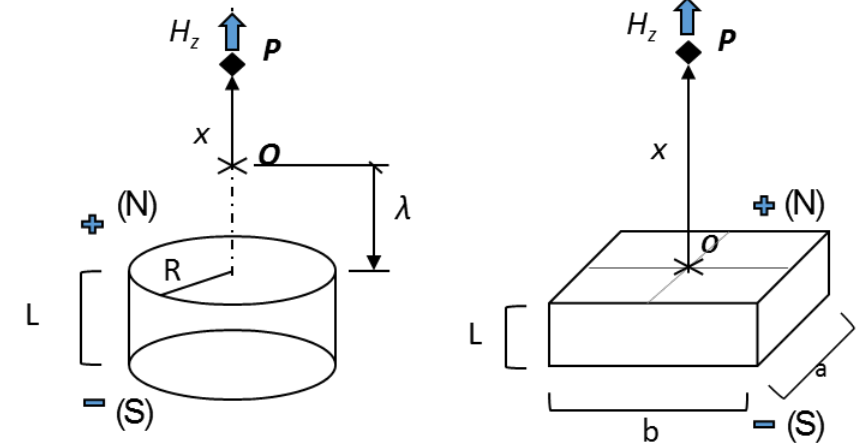
Figure A1. Analytical general model for axial field calculation of (left) a cylinder magnet with axial magnetization and (right) a rectangular magnet.